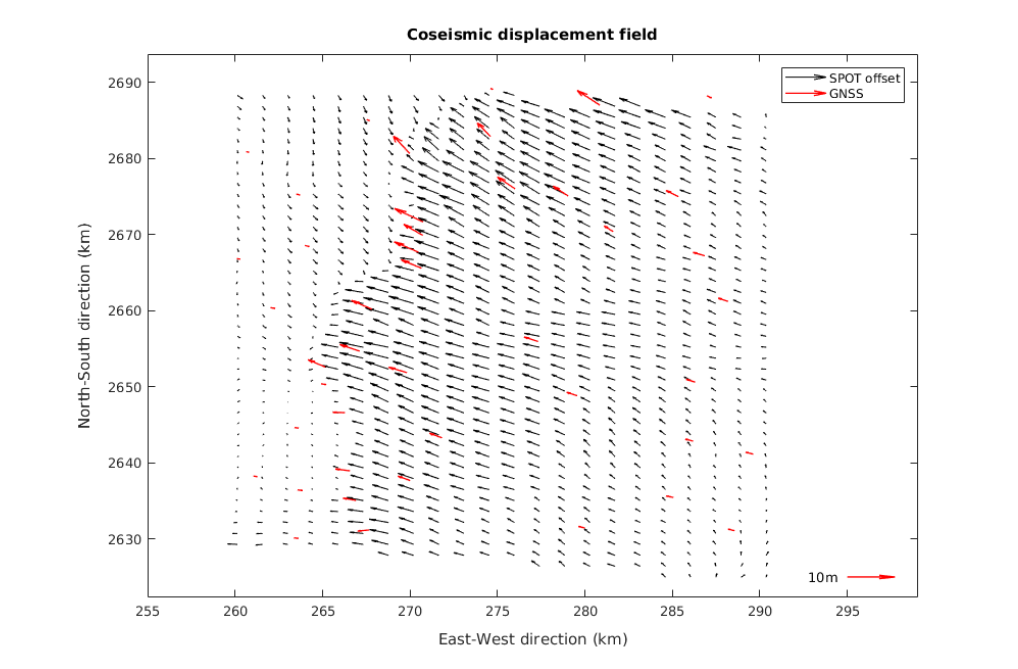
Figure 6. Coseismic displacement vectors, black arrows represent SPOT offsets and red arrows GPS